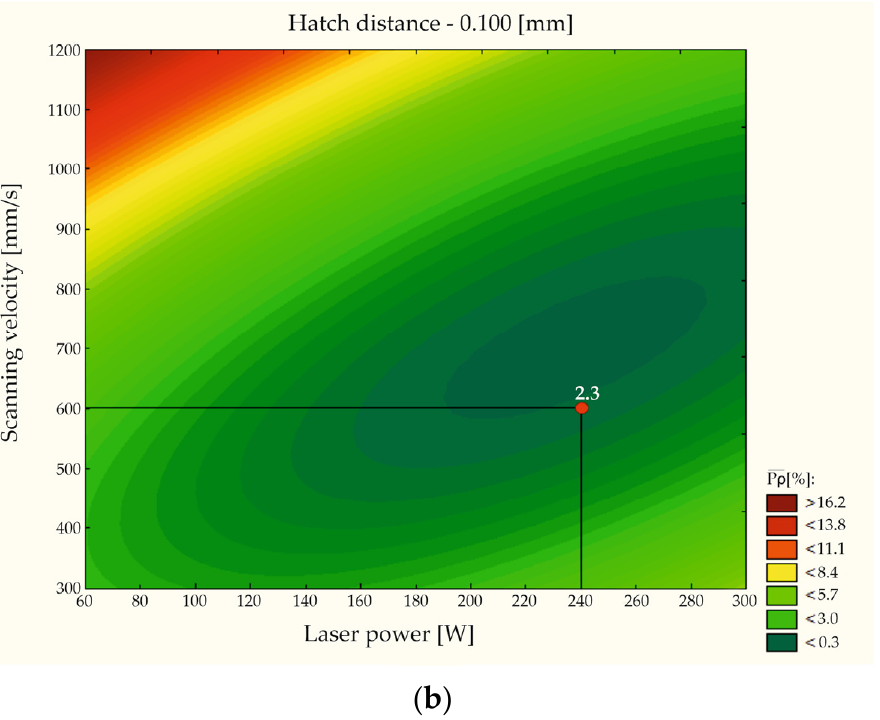
Figure 3. Answer surfaces generated for the constant value of the following hatching distance parameters: ( a ) h d = 0.0110 mm and ( b ) h d = 0.0100 mm.